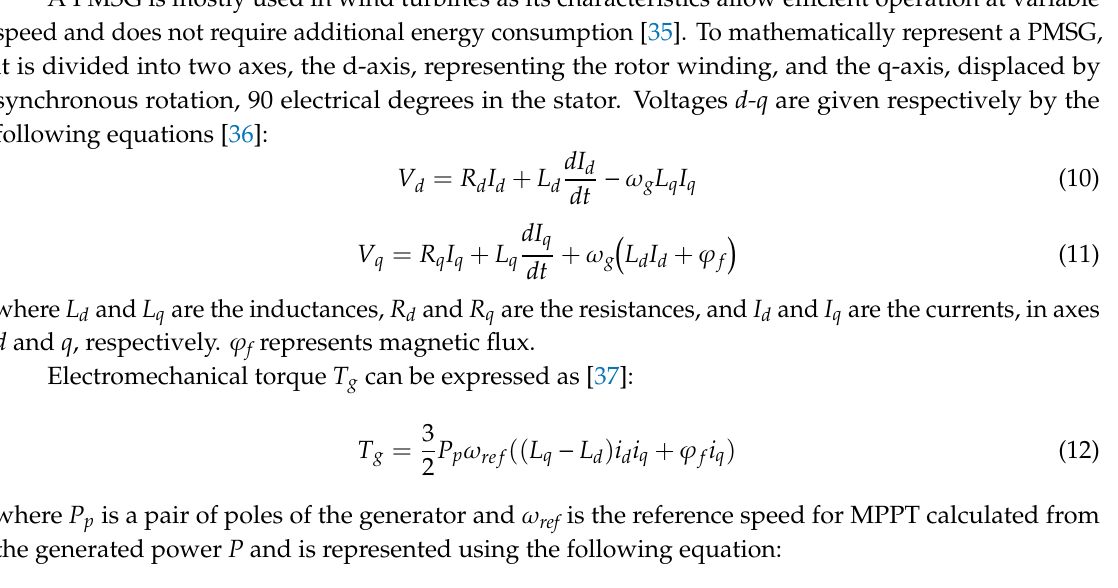
Figure 2. Operating regions of a wind turbine. In region III, pitch control is used to counteract strong winds and keep the nominal rotation speed constant.